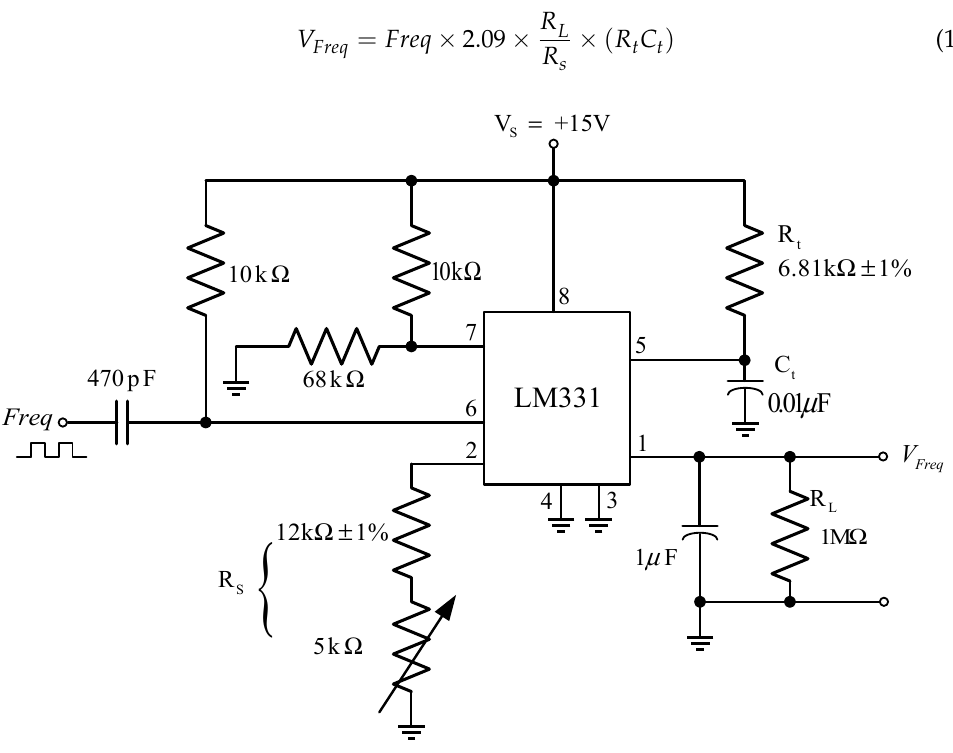
Figure 29. Frequency to voltage conversion circuit [25].